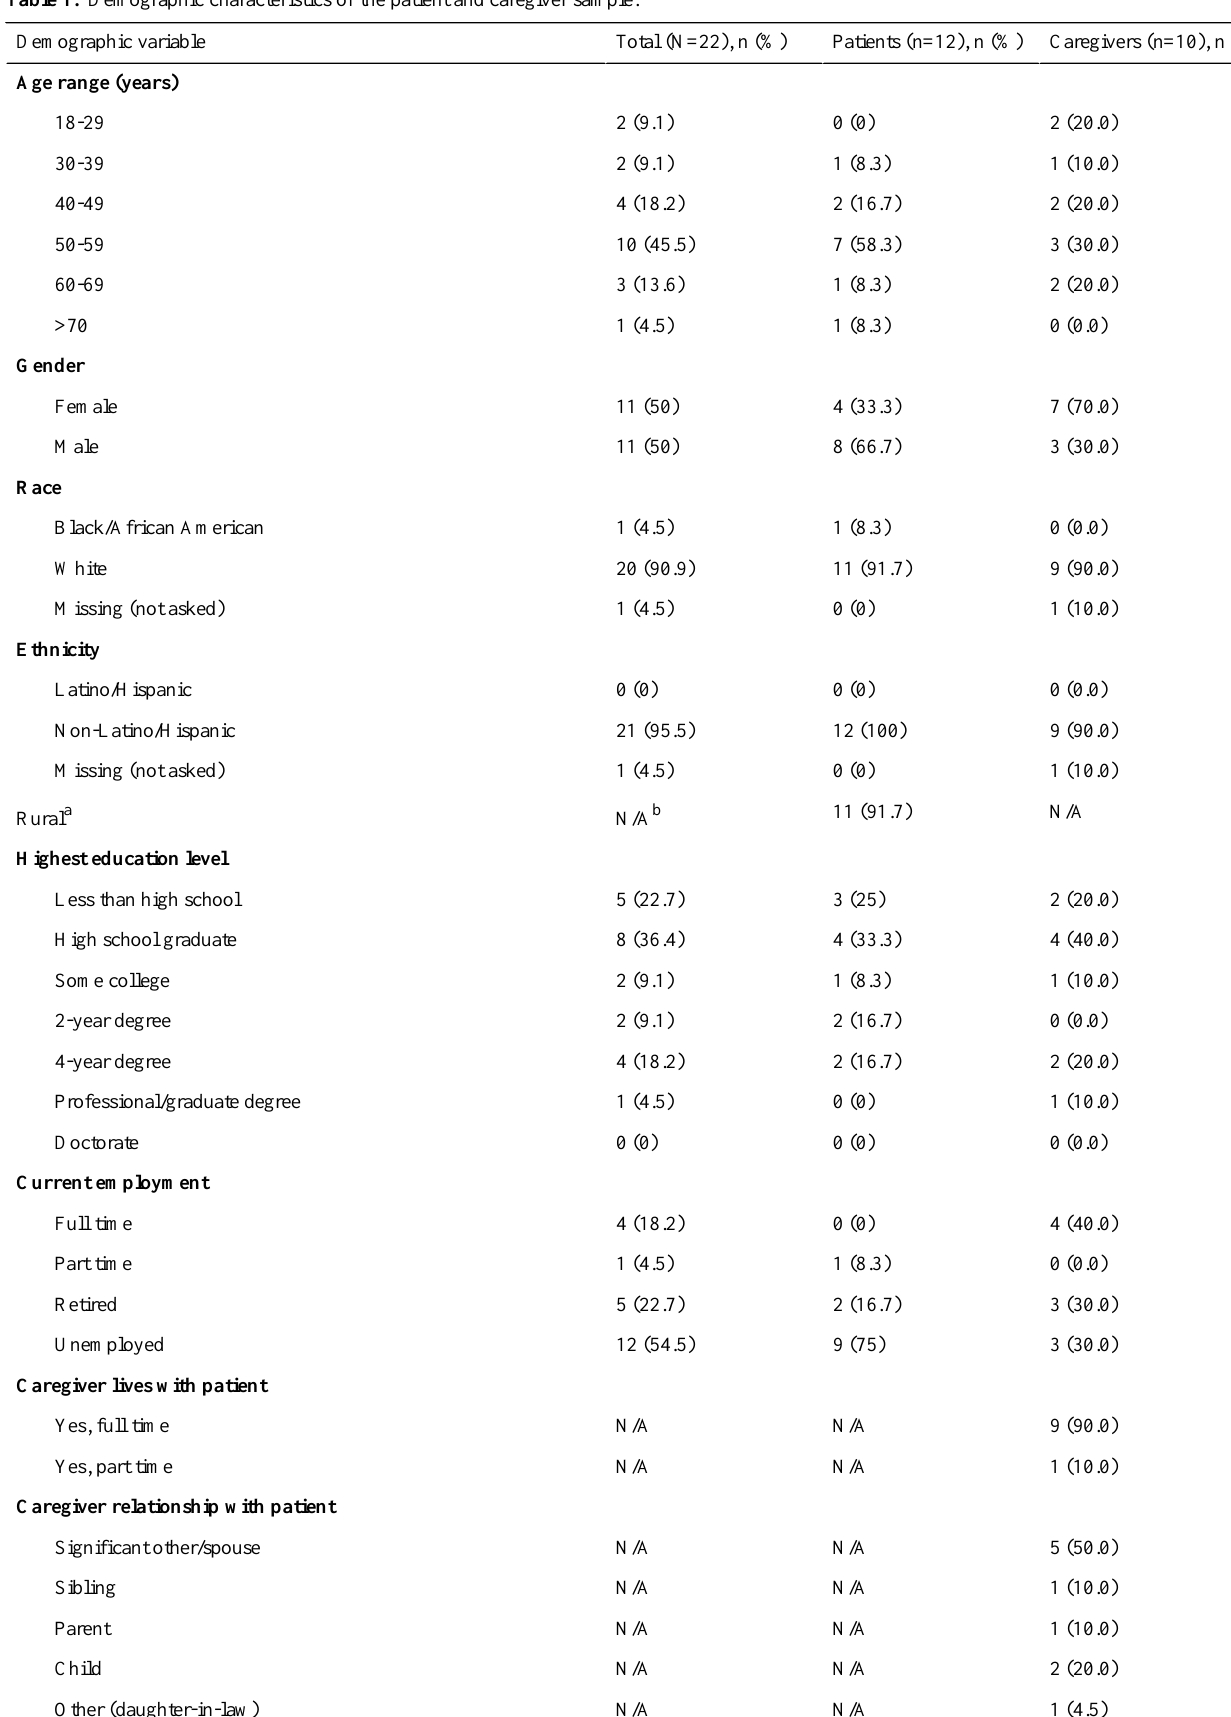
Table 1. Demographic characteristics of the patient and caregiver